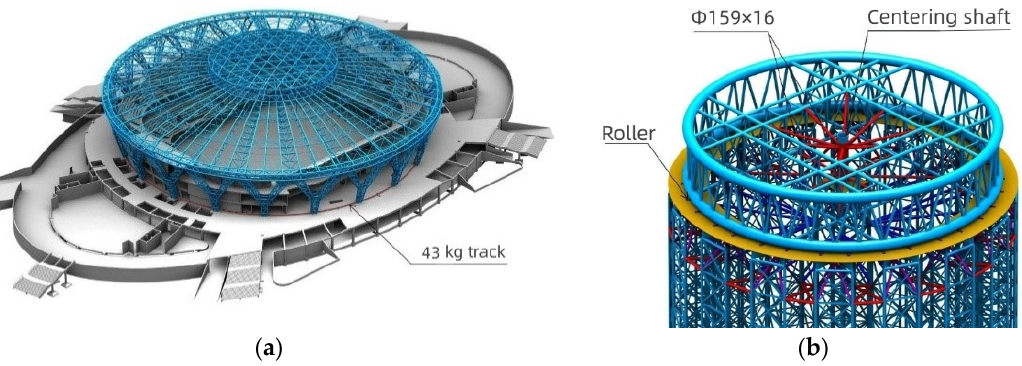
Figure 5. Schematic diagram of the slip system. ( a ) Outer ring slip track arrangement, ( b ) central ring-supported tire frame.